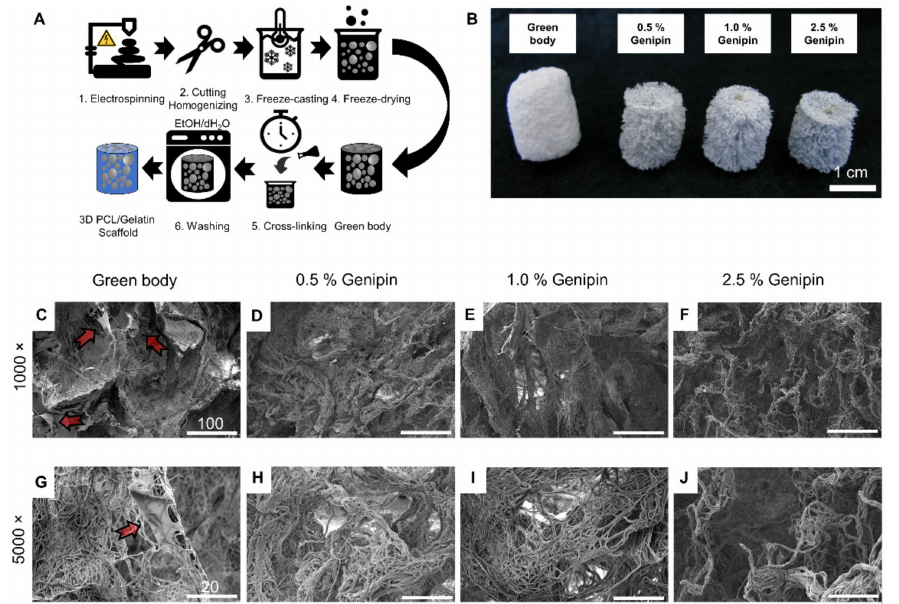
Figure 1. Preparation and morphology of 3D PCL/gelatin scaffolds. ( A ) Schematic illustration of the fabrication process. ( B ) Influence of different cross-linker concentrations on scaffold color and morphology, scale bar = 1 cm. ( C – J ) SEM images of cross-sections: ( C , G ) scaffolds prior to cross-linking (green body), arrows show polymer sheets in-between the fibers and cross-linked with 0.5% ( D , H ), 1.0% ( E , I ), and 2.5% genipin ( F , J ); ( C – F ) scale bar = 100 µ m, ( G – J ) scale bar = 20 µ